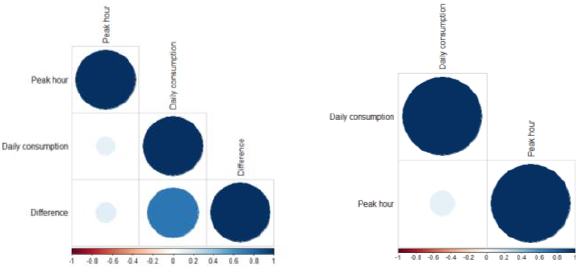
Figure 4. Feature selection from load profile characteristics of residential